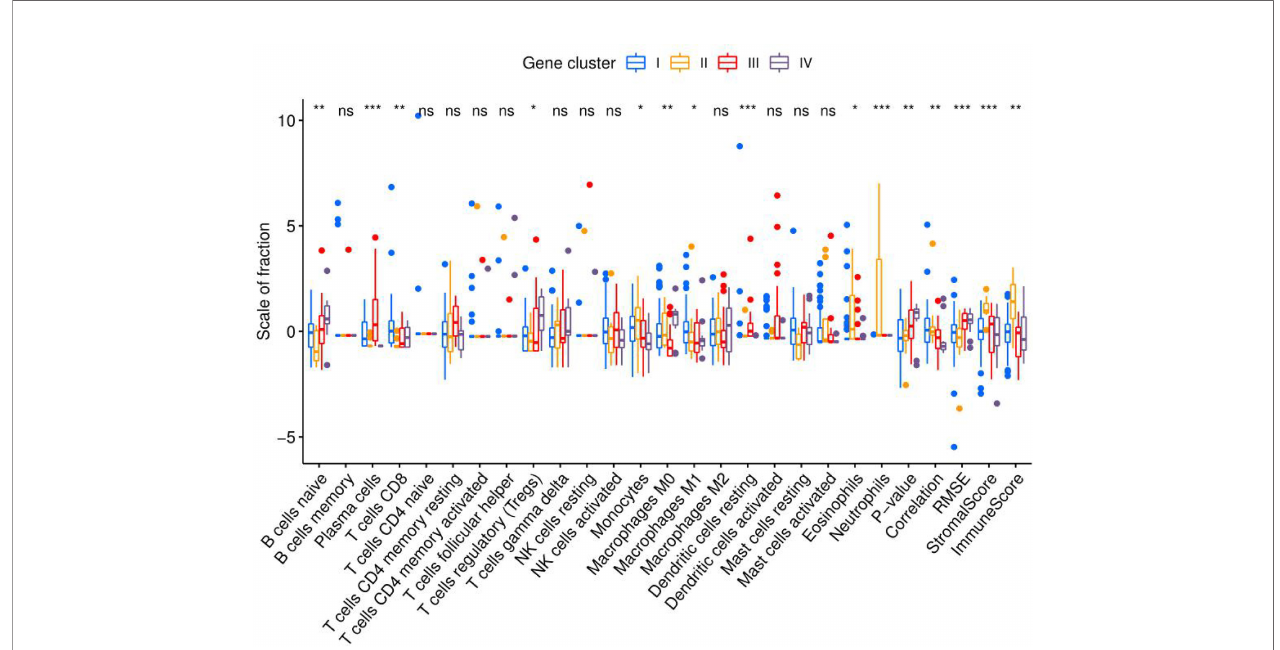
FIGURE 10 | Immune cell in fi ltration in molecular subtypes I, II, III, and IV. Eosinophils, neutrophils, and monocytes of molecular subtype II were signi fi cantly more abundant than those in the other molecular subtypes. The ratio of M1 macrophages to M2 macrophages was ranked as follows: subtypes IV < II < III < I. (*P < 0.05; **P < 0.01; ***P < 0.001; ns, not signi fi